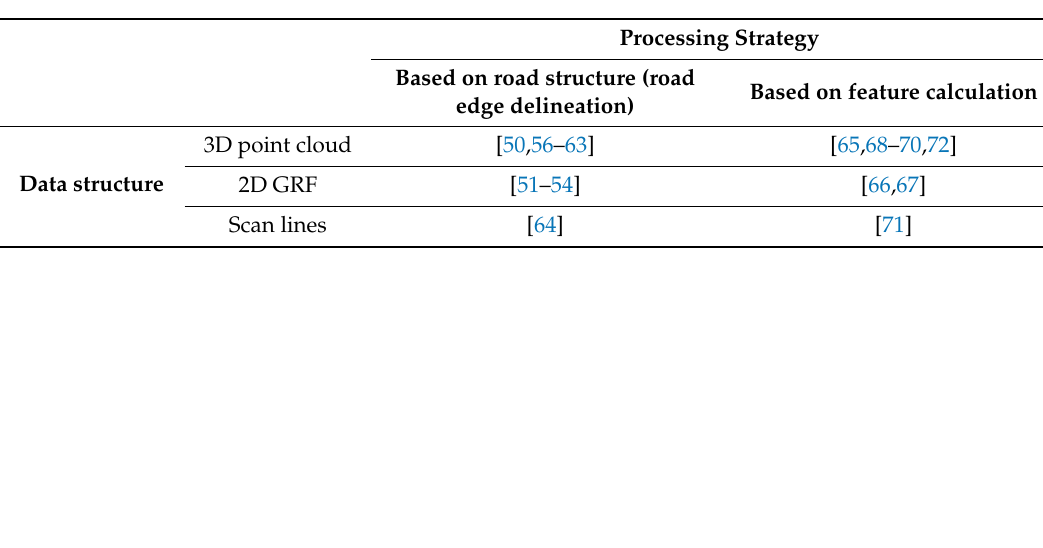
Table 2. Summary of state-of-the-art works for road surface